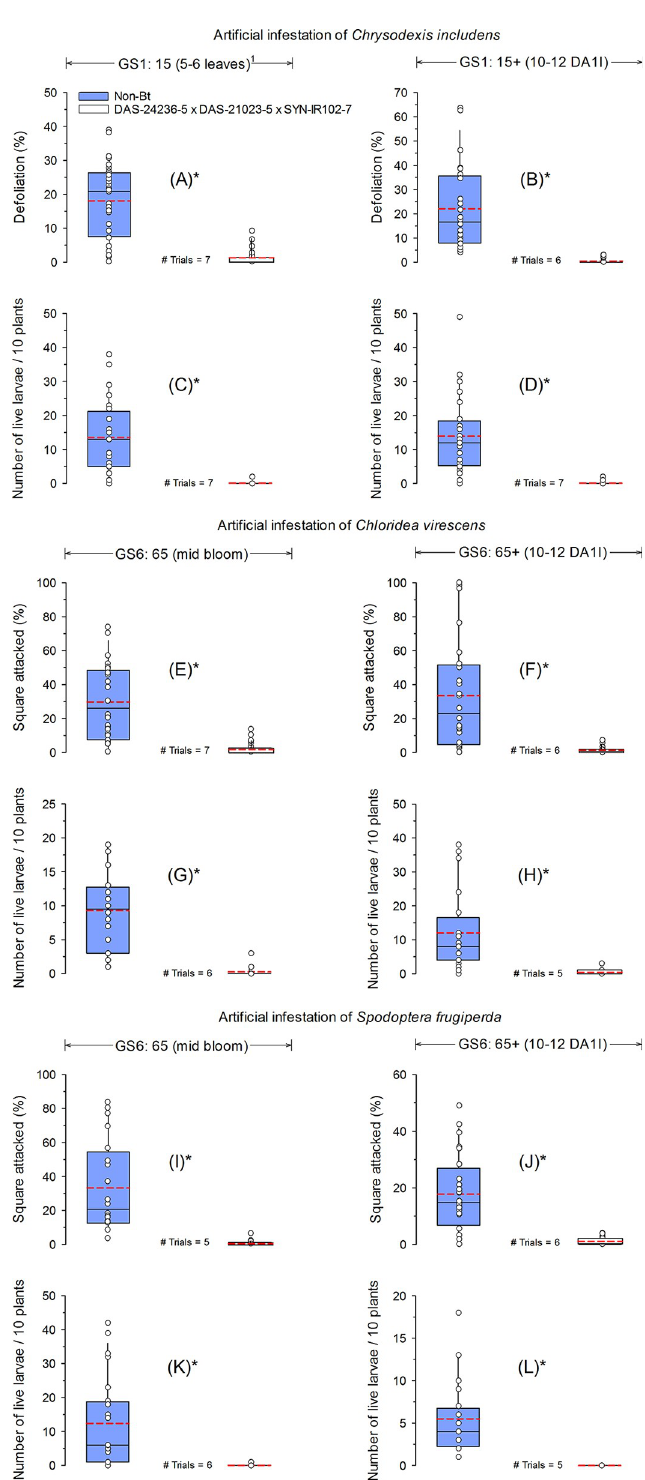
Fig 1. Efficacy of Bt cotton technology with events DAS-21023-5 × DAS-24236-5 × SYN-IR102-7 against Chrysodeixis includens , Chloridea virescens and Spodoptera frugiperda at 10 days after artificial infestation of first instar (L1) during vegetative and reproductive cotton growth stages. The dashed (red) and solid (black) lines in boxplots represent the mean and median across trials, respectively. Dot markers indicate values from individual trials. � Significant difference between non- Bt and Bt cotton technology using an F -test ( α = 0.05). 1 Phenological growth stages of cotton classified according to Munger et al. (1998); DA1I = days after 1 st infestation.